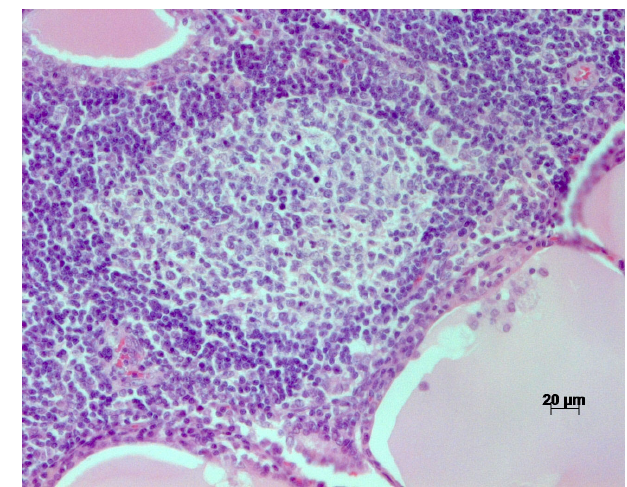
Figure 3. H&E stain of the thyroid of a rhesus macaque with chronic lymphocytic thyroiditis: focal lymphocytic infiltrates with germinal centers within the tissue.